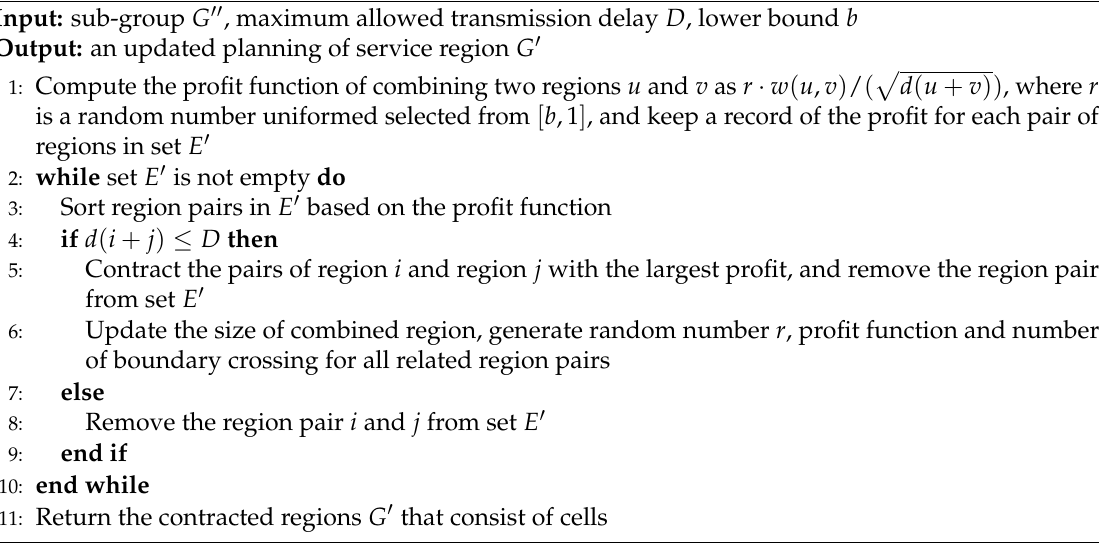
Algorithm 2 Service Region Re-group Algorithm (SRR)